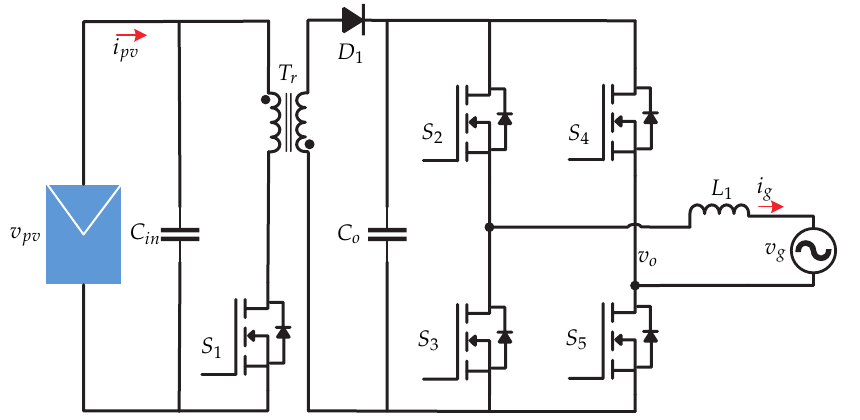
Figure 12. Microinverter’s topology proposed in [21–24].